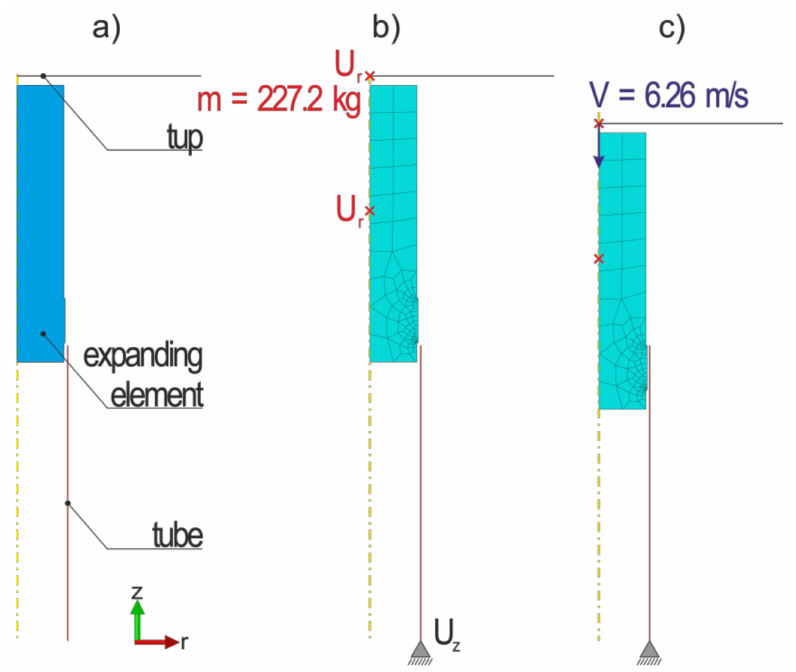
Figure 3. FEM computational model: ( a ) geometric model; ( b ) discrete model; ( c ) position of the element before the proper dynamic